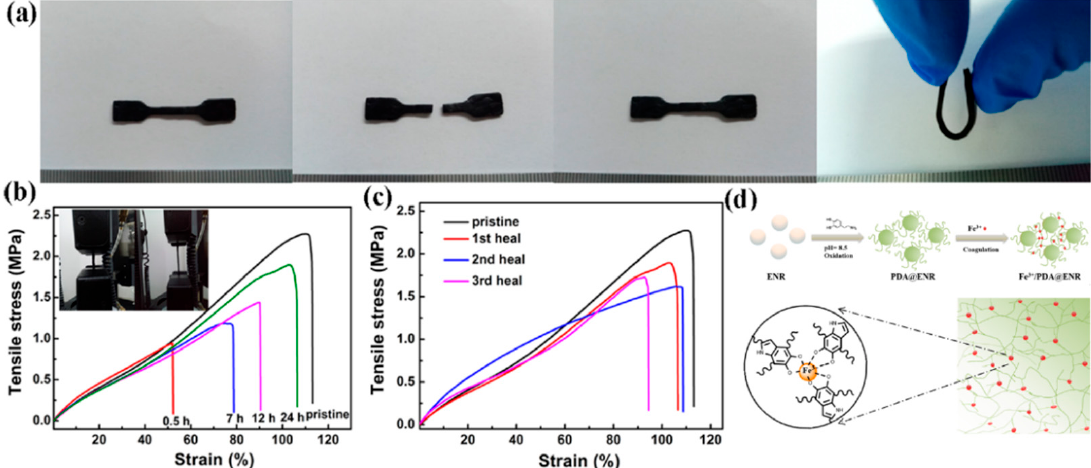
Figure 8. ENR/PDA with Fe 3+ elastomers and their mechanical properties; ( a ) self-healing testing of ENR/PDA with Fe 3+ sample, ( b ) the stress–strain curves of ENR samples at various self-healing times, ( c ) the stress–strain curves of ENR samples with various samples of self-heating, and ( d ) the model of ENR/PDA with Fe 3+ system [89]. Adapted with permission from [89]. Copyright 2017 American Chemical Society.